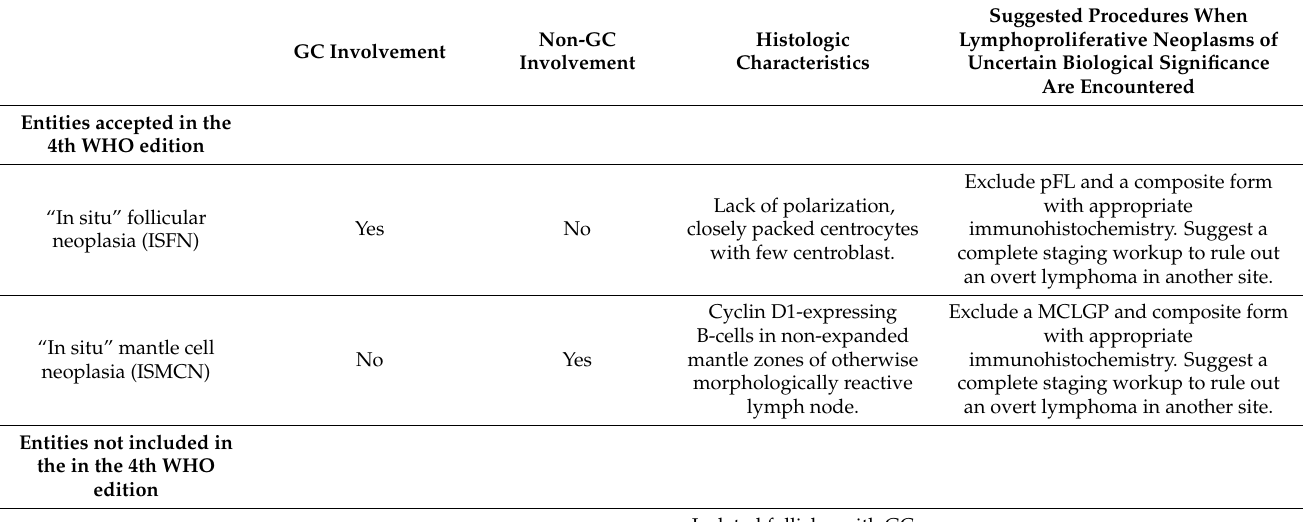
Table 1. Lymphoproliferative neoplasms of uncertain biological